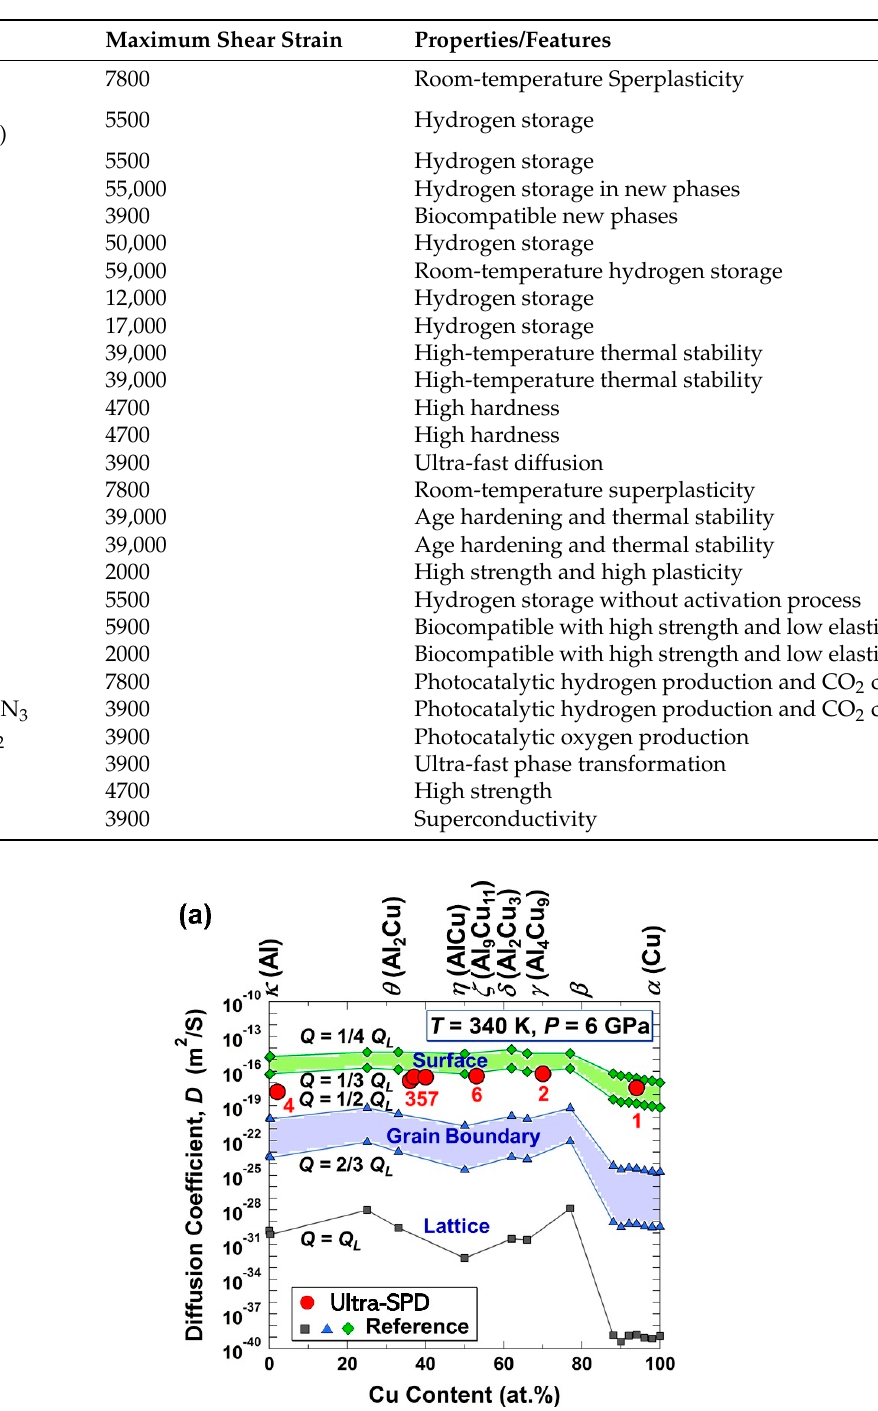
Figure 1. Ultra-fast diffusion during ultra-SPD. Estimated diffusion coefficients during ultra-SPD processing via HPT (red circles) for ( a ) Al-Cu alloy plotted against Cu content and ( b ) Al-Zr alloy plotted against pressure in comparison with the reference data calculated using activation energy for lattice diffusion Q L , grain boundary diffusion (1/2–2/3) Q L , and surface diffusion (1/4–1/3) Q L [24,26]. 2.1. Thermal Stability in New Immiscible Age-Hardenable Aluminum Alloys UFG materials processed by SPD, particularly materials with low melting tempera- tures such as Al-based alloys, exhibit high hardness, but they usually suffer from poor thermal stability at high temperatures [62–64] or even sometimes at ambient temperature during elongated periods [65–67]. It has been a target of many studies to produce Al-based alloys with high strength and high thermal stability for lightweight applications [68]. The microstructure can be stabilized by second-phase particles of an immiscible element, but due to the immiscibility effect, such alloys show negligible solid solution hardening and poor age hardening [69–72]. Ultra-SPD provides an effective path to achieve supersatura- tion in various Al-based alloys such as Al-Ca [55], Al-Fe [49], Al-Zr [26], and Al-La-Ce [56]. Such a supersaturation can lead to an enhanced solution hardening effect in these alloys. Moreover, further aging of these supersaturated alloys can result in the precipita- tion of the second phase particles which not only enhance age hardening but also improve thermal stability. Figure 2 shows the results achieved using ultra-SPD via the HPT method for an im- miscible Al-5Zr (wt%) alloy [26]. The hardness of samples processed with conventional